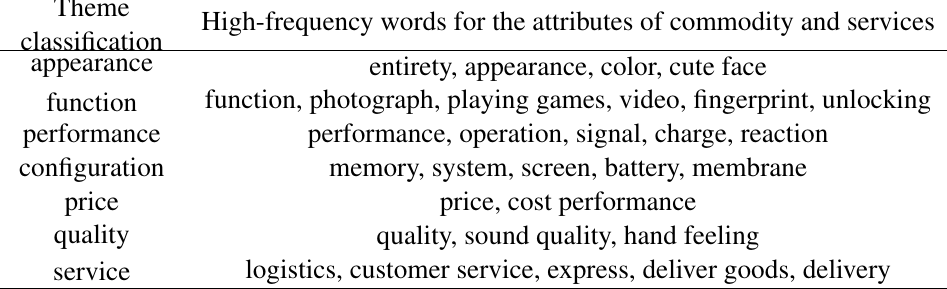
Table 2 The attributes classification of commodity or